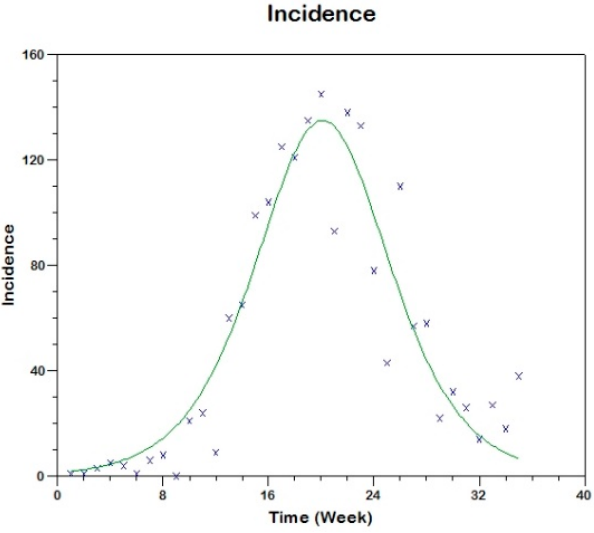
Figure 11 . Model fit to the reported incidence rate of the first outbreak in Tolima-Colombia using Method 1.